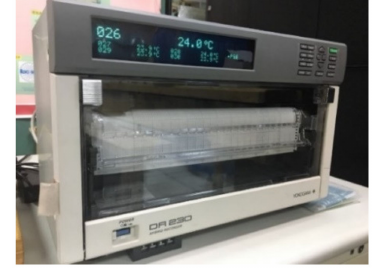
Figure 4. Hybrid recorder DR230.